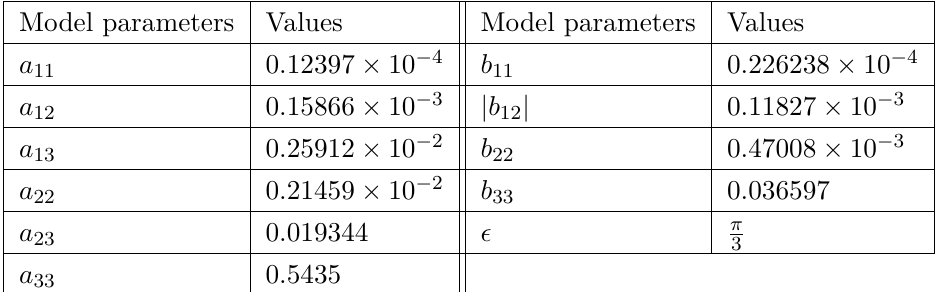
Table 6 . Parameters of the quark and charged leptons Yukawa matrices at the GUT scale with tan β = 5 .